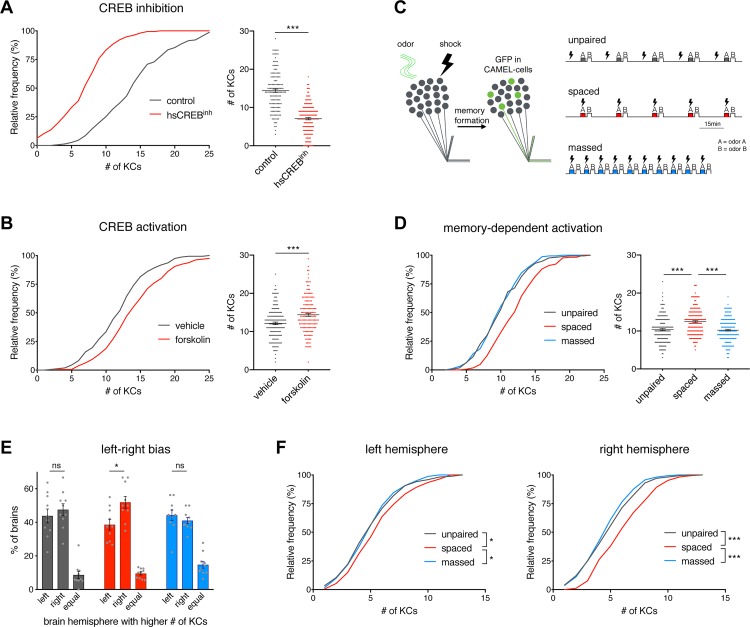
CREB2 and LTM-dependent CAMEL activity.(A) Expression of an inhibitory CREB2 isoform (CREB2b) significantly decreased the number of labeled CAMEL neurons (n ≥ 143). (B) In contrast, elevated cAMP signaling via forskolin feeding increased labeling of CAMEL neurons (n ≥ 158). (C) Schematic drawing of experimental principle and conditioning protocols. (D) Only spaced paired conditioning resulted in increased CAMEL activity (n ≥ 162). (E) In contrast to control groups (unpaired trained, grey bars; massed trained, blue bars), spaced trained flies (red bars) show a bias towards increased labeling in the right hemisphere (n ≥ 10). (F) Analysis of both brain hemispheres separately revealed that LTM formation protocols led to increased CAMEL activity in both the left and the right brain hemispheres, with stronger effects in the right brain hemisphere (n ≥ 162). (A–F; 6xCREAD∩R21B06DBD > EGFP). Bars and horizontal lines represent mean ± SEM. Asterisks indicate significant differences between relevant groups (*P < 0.05, ***P < 0.001, Mann-Whitney [A, B], Kruskal-Wallis [D, F], or unpaired t test [E]). CAMEL, CRE-activity–dependent memory engram label; CRE, cAMP response element; CREB2, cAMP response element binding protein 2; EGFP, enhanced green fluorescent protein; KC, Kenyon cell; LTM, long-term memory; SEM, standard error of the mean.